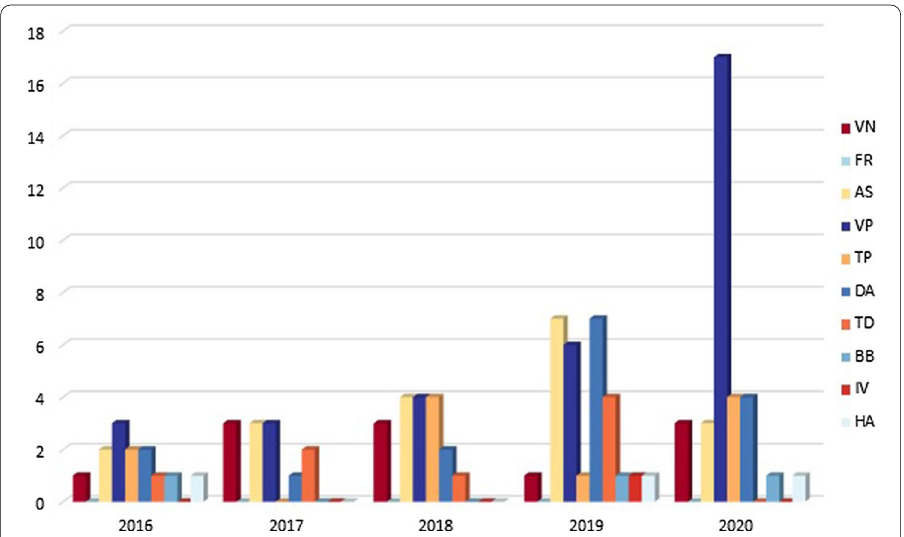
Fig. 2 Evolution of student generated video styles over the years (from 2016 to